Question: In one sentence, what is this figure communicating?
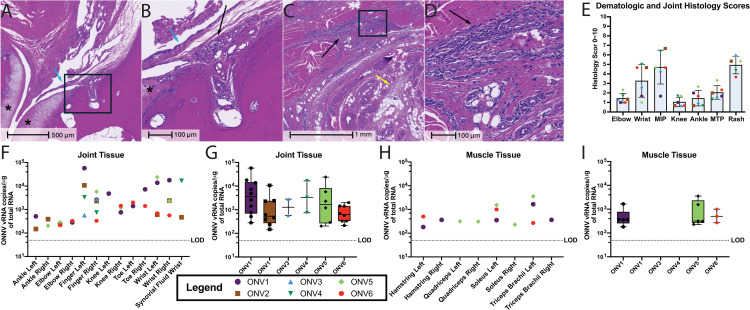
Answer: Histopathological and virological assessment of ONNV-infected joints and muscles. Representative images of finger tissue at 14 dpi stained with H&E displaying joint inflammation. Histologic analysis of a carpal interphalangeal joint from ONV5 at low ( A ) and high ( B ) magnification revealed sub-synovial lymphocytic inflammation (black arrow) with minimal focal hypertrophy of the overlying synovium (blue arrow). The articular surfaces (black asterisk) were unaffected. Lymphoplasmacytic and neutrophilic inflammation evident at low ( C ) and high ( D ) magnification extended within the tendon (black arrows) and adipose tissue (yellow arrow) of ONV4. ( E ) Combined histology scores averaged across three scores for selected tissues. Sections were evaluated for perivascular lymphoid aggregates, inflammation, and synovial hypertrophy or hyperplasia. Severity scores were assigned on a scale of 0-10, as described in S2 Table , with 0 indicating the absence of any changes, 1-2 scarce, 3-4 minimal, 5-6 mild, 7-8 moderate, and 9-10 severe. Viral loads (from S1 Table ) were quantified using one-step RT-qPCR. The limit of detection (LOD) was 50 copies of ONNV RNA. Graphs represent tissues with at least one animal positive for viral detection and are separated into five tissue types. Joint and muscle tissues were summarized separately ( G, I ) .